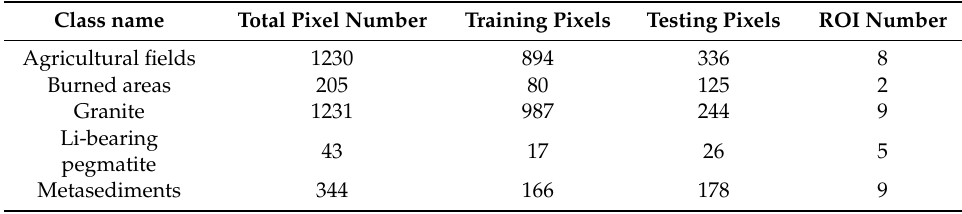
Table 2. Distribution of Training Pixels by Classes and regions of interest